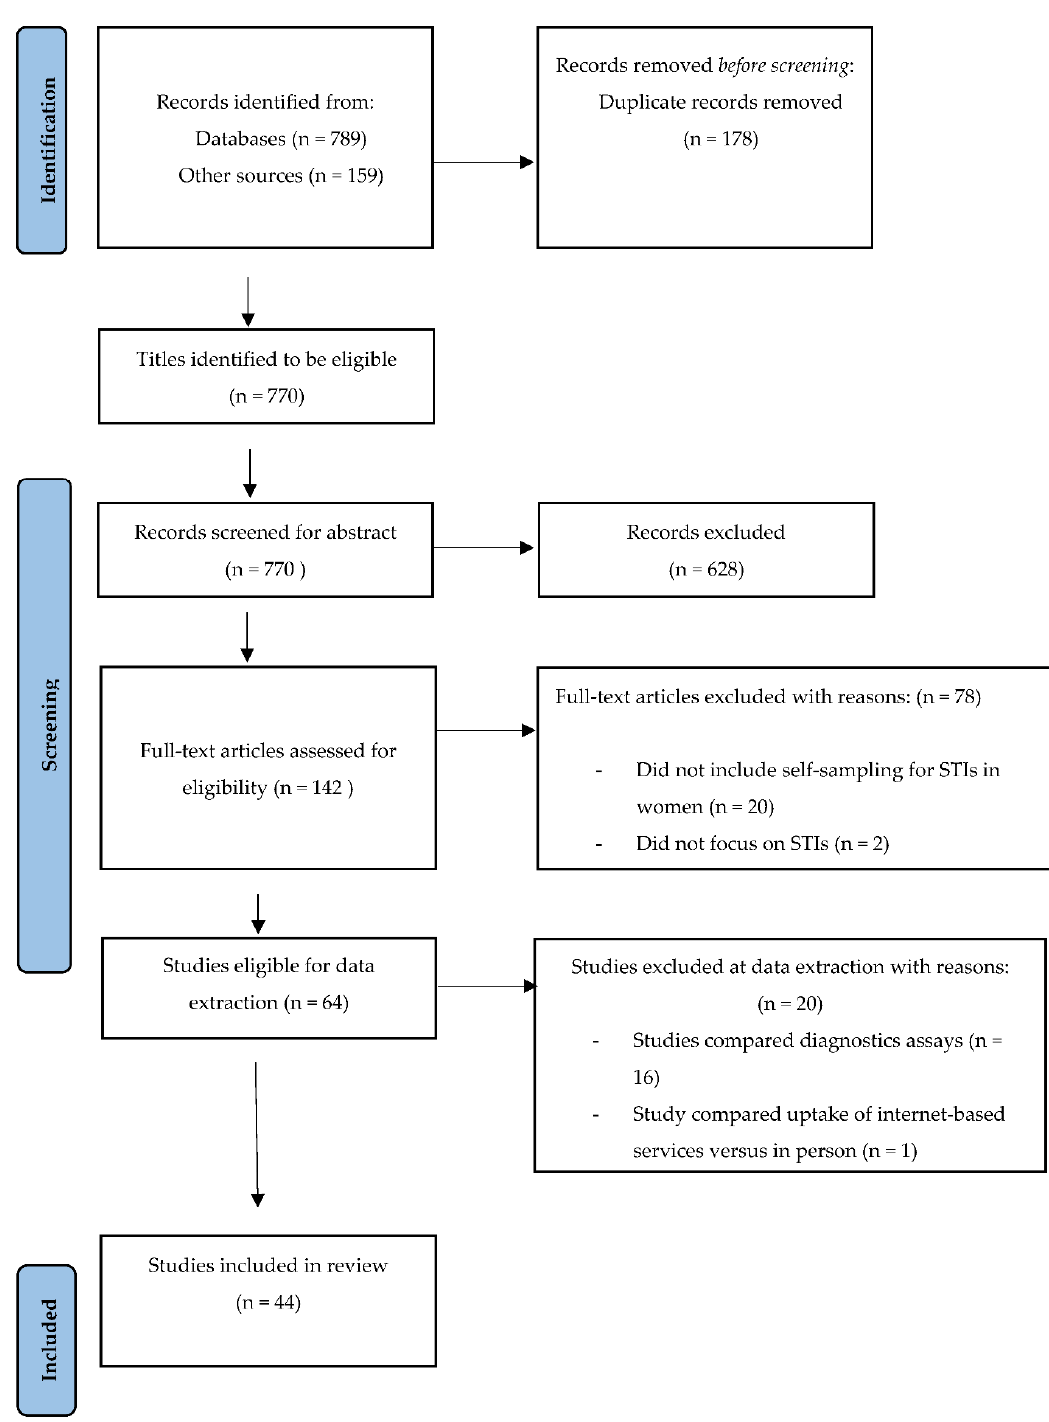
Figure 1. Preferred Reporting Items for Systematic Reviews and Meta-Analyses (PRISMA) flow di- agram of the study selection process .